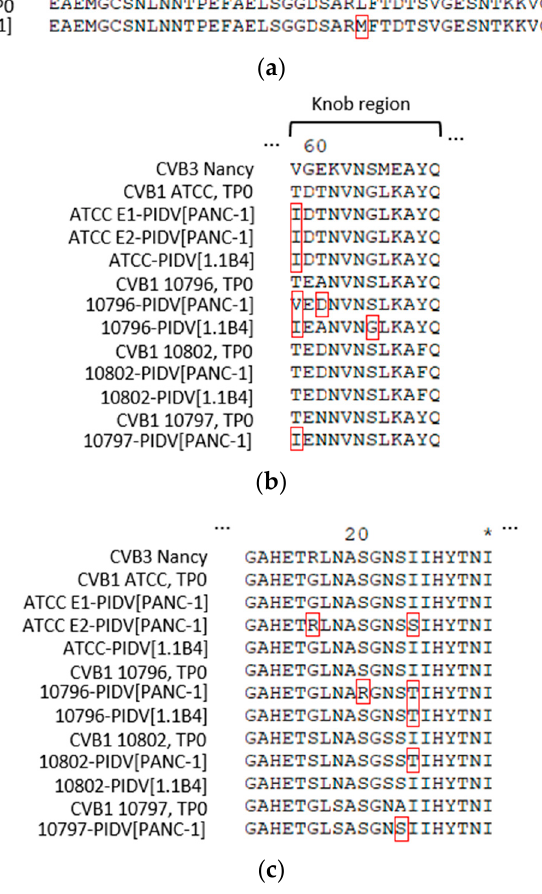
Figure 7. Mutations of PIDVs in capsid proteins VP2-4 in TP2. ( a ) Mutations on VP2 puff region. ( b ) Mutations on VP3 knob region. ( c ) Mutations on VP4 infection-enhancing epitope AA 11-30.